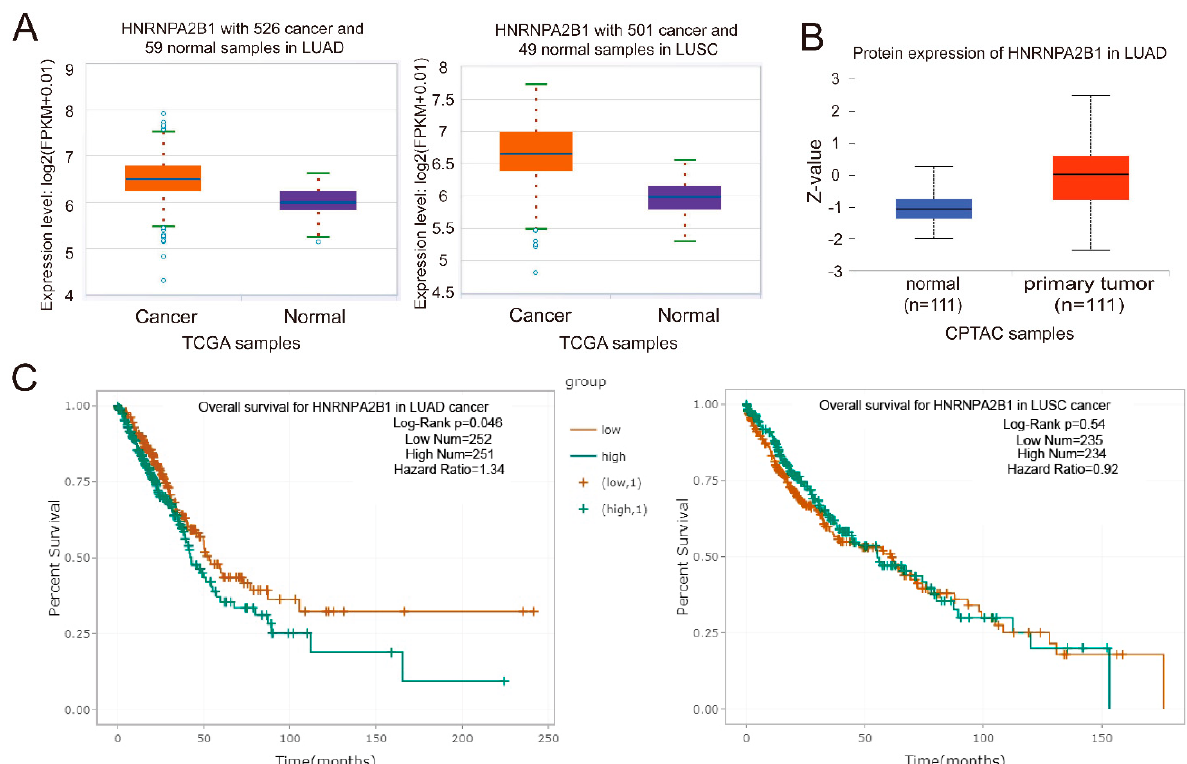
Figure 6. The expression of hnRNPA2B1 is closely related to lung cancer progress. ( A ) The expression levels of hnRNPA2B1 mRNA in LUAD and LUSC patients compared with normal controls (from TCGA database). ( B ) The expression levels of hnRNPA2B1 protein in LUAD patients compared with normal controls (from CPTAC database). ( C ) The overall survival rates of LUAD and LUSC patients with high or low expression levels of hnRNPA2B1 mRNA.